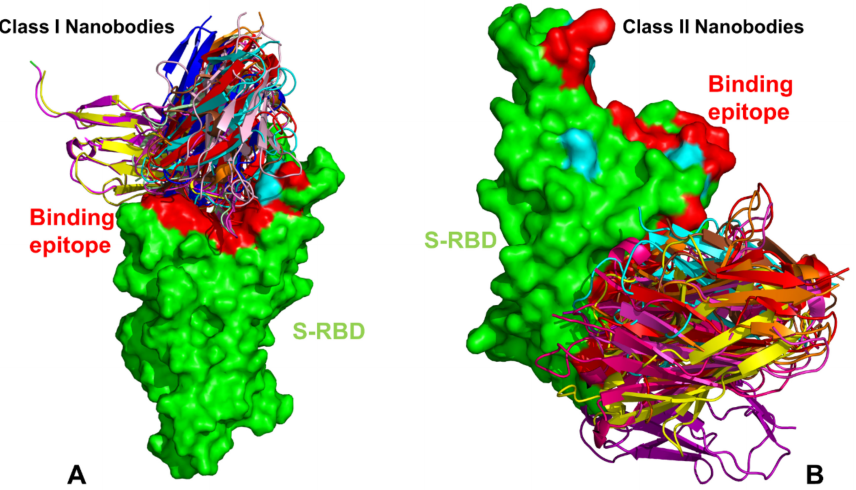
Figure 2. Structural classification and superposition of the SARS-CoV-2 S-RBD complexes with high- affinity nanobodies. ( A ) Structural superposition of the S-RBD complexes with class I nanobodies targeting the ACE2-binding region. The representative class I nanobodies shown are Nb6 (pdb id 7KKK), Nb20 (pdb id 7JVB), Sb45 (pdb id 7KLW), MR17 (pdb id 7C8W), SR4 (pdb id 7C8V), Sb14 (pdb id 7MFU), Sb16 (pdb id 7KGK), WNb2 (pdb id 7LX5), VHH-E (pdb id 7B14), C2 (pdb id 7OAO), H3 (pdb id 7OAP), NM1230 (pdb id 727), and Nanosota-1 (pdb id 7KM5). The S-RBD is shown in green surface. The superimposed nanobodies are shown in ribbons. A typical binding epitope for this class of nanobodies is shown in red-colored surface. The positions of K417, E484, and N501 are shown in cyan-colored surface on the RBD. For clarity, only E484 can be seen. ( B ) Structural superposition of the S-RBD complexes with class II nanobodies targeting the cryptic binding site in the core RBD region. The representative class II nanobodies shown included: C1 (pdb id 7OAP), F2 (pdb id 7OAY), Sb68 (pdb id 7KLW), VHH-U (pdb id 7KN5), VHH-V (pdb id 7KN6), VHH-W (pdb id 7KN7), NM1226 (pdb id 7NKT), WNb10 (pdb id 7LX5), and SR31 (pdb is 7D2Z). The S-RBD is shown in green surface. The superimposed nanobodies are shown in ribbons. Both ACE2-binding epitope and class II binding epitopes are shown in red-colored surface. The positions of K417, E484, and N501 are shown in cyan-colored surface on the RBD. The class II nanobodies target the S-RBD core region that is distinct from the ACE2- binding